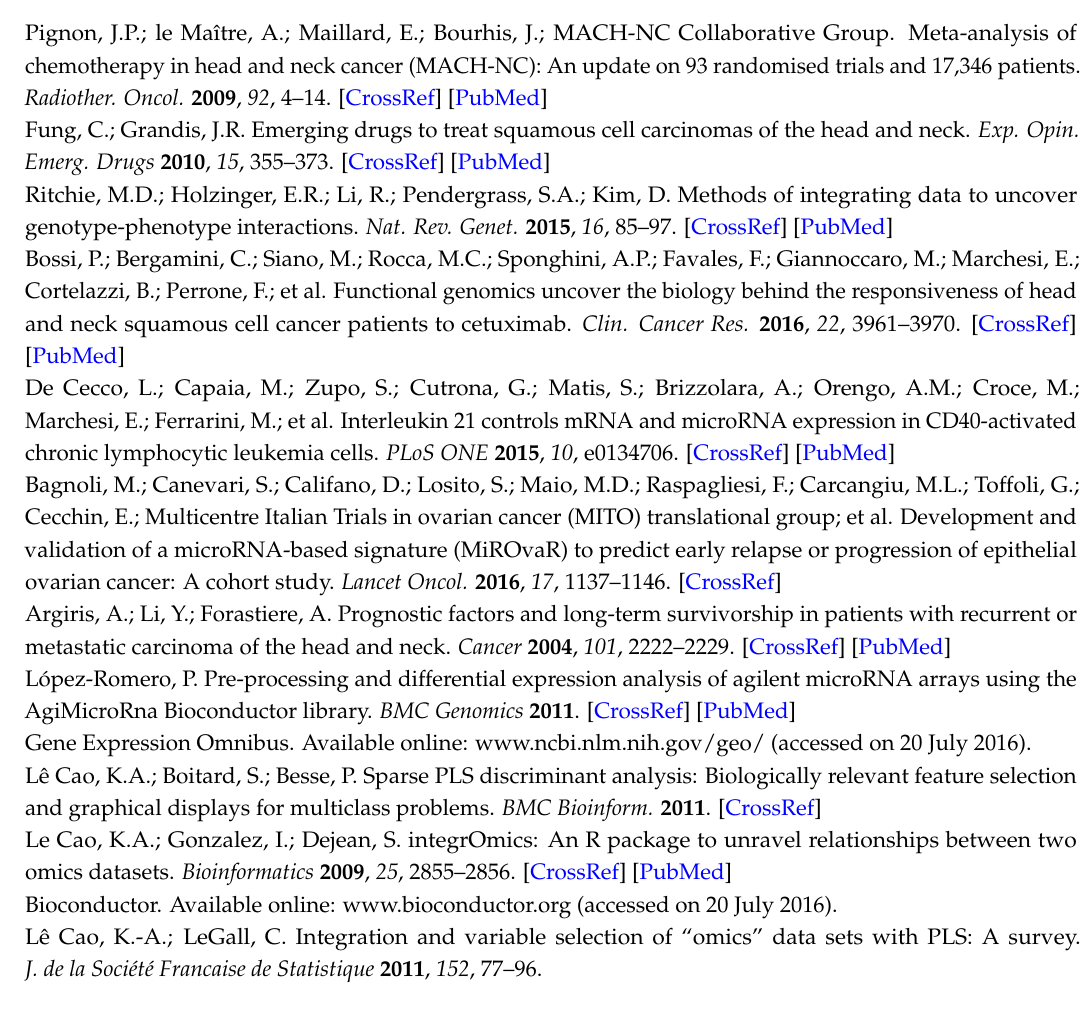
Figure S1: Tuning of parameters for rCCA, Figure S2: Volcano plot for the 614 miRNA detected by microarray analysis, Figure S3: Gene expression sPLS-DA in patients treated with cetuximab, Table S1: miRNA identified by supervised analysis using sPLS-DA and by supervised class comparison analysis, Table S2: List of 27 miRNA and 250 genes identified by rCCA, Table S3: List of the 245 interactions disclosed by MAGIA2